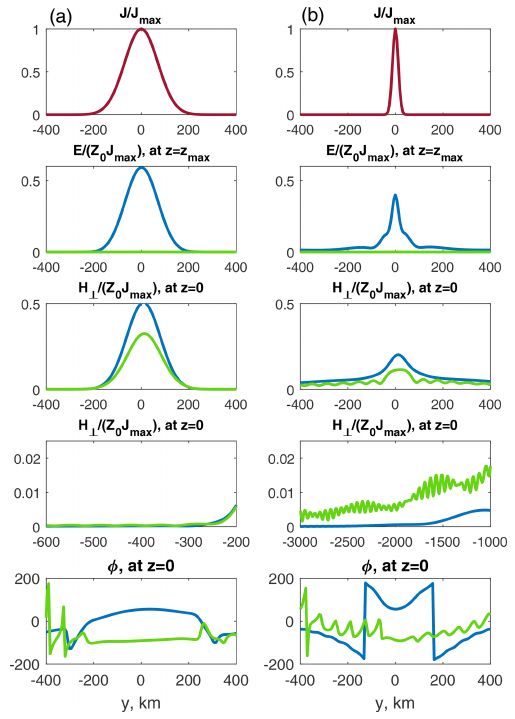
Figure 5. Current density (red line) and field space distributions at x = 0 for two different ratios J y /J x , outlined by green ( J y /J x = 1) and blue ( J y /J x (cid:39) − i ) colors. Left plot column (a) corresponds to the L y = 70 km ≥ 1 /k 0 source scale and right plot column (b) cor- responds to the L y = 12km ≤ 1 /k 0 source